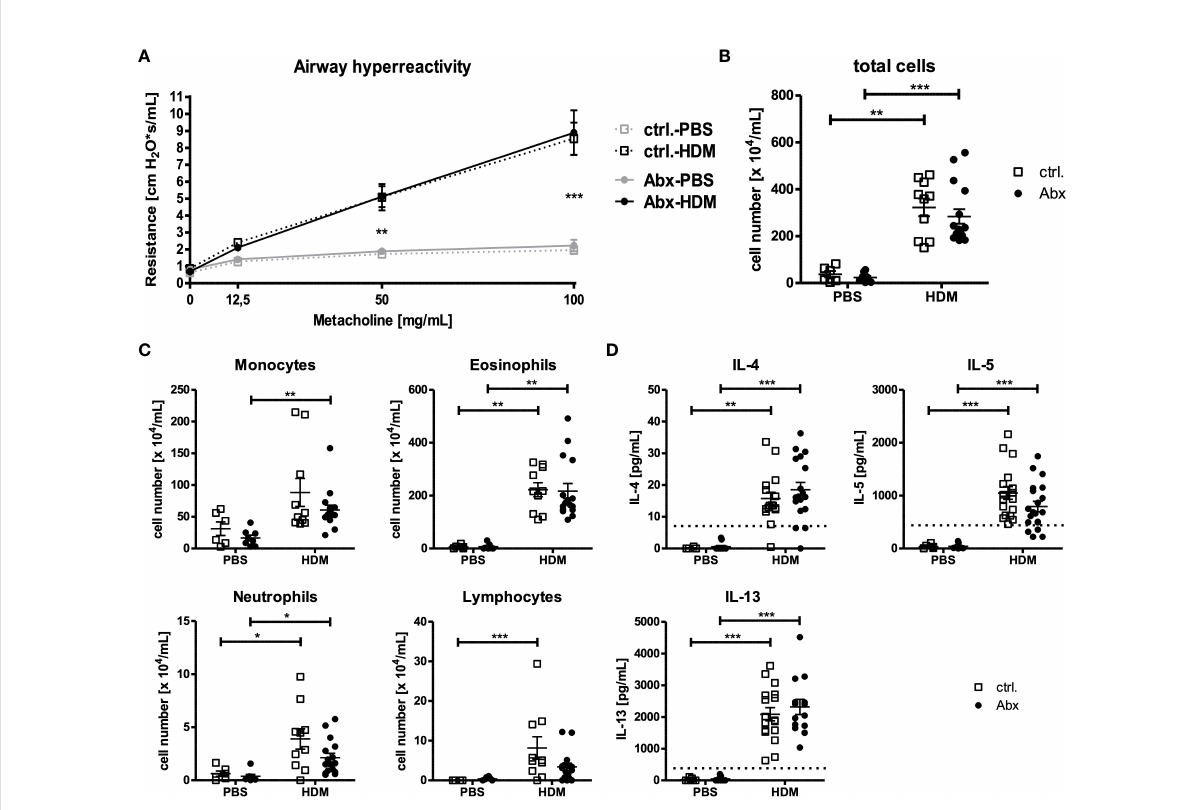
FIGURE 2 Prenatal antibiotic exposure of dams does not in fl uence the asthma phenotype of the offspring. C57BL/6 mice were treated with vancomycin, ampicillin and gentamycin (all at 1.0 mg/mL)(Abx) from prenatal day 15 until birth. Mice treated with sucralose served as controls (ctrl.). At 6-8 weeks, offspring C57BL/6 mice were immunized i.p. with 10 µg/100 µL of HDM. Seven days later mice received an additional i.p. injection of HDM. After 14 and 21 days, mice were treated with 100 µg/40 µL HDM i.t. Mice treated with PBS served as non-asthmatic controls. 72 h after the last treatment AHR in response to i.t. administration of methacholine measured as airway resistance using Flexivent (A) , cellular in fi ltration of the airways (B, C) and cytokine production of single lung cell suspensions after 72 h ex vivo cell culture (D) were assessed. Scatter plot with mean ± SEM, n = 6-18 mice. Each dot represents one mouse. Dotted lines (D) indicate the detection limit. Differences between groups were tested by two-way ANOVA and Bonferroni Post Test (A) or Kruskal-Wallis-Test and Dunns ’ s Post Test (B – D) for signi fi cance; * p < 0.05, ** p < 0.01, *** p <